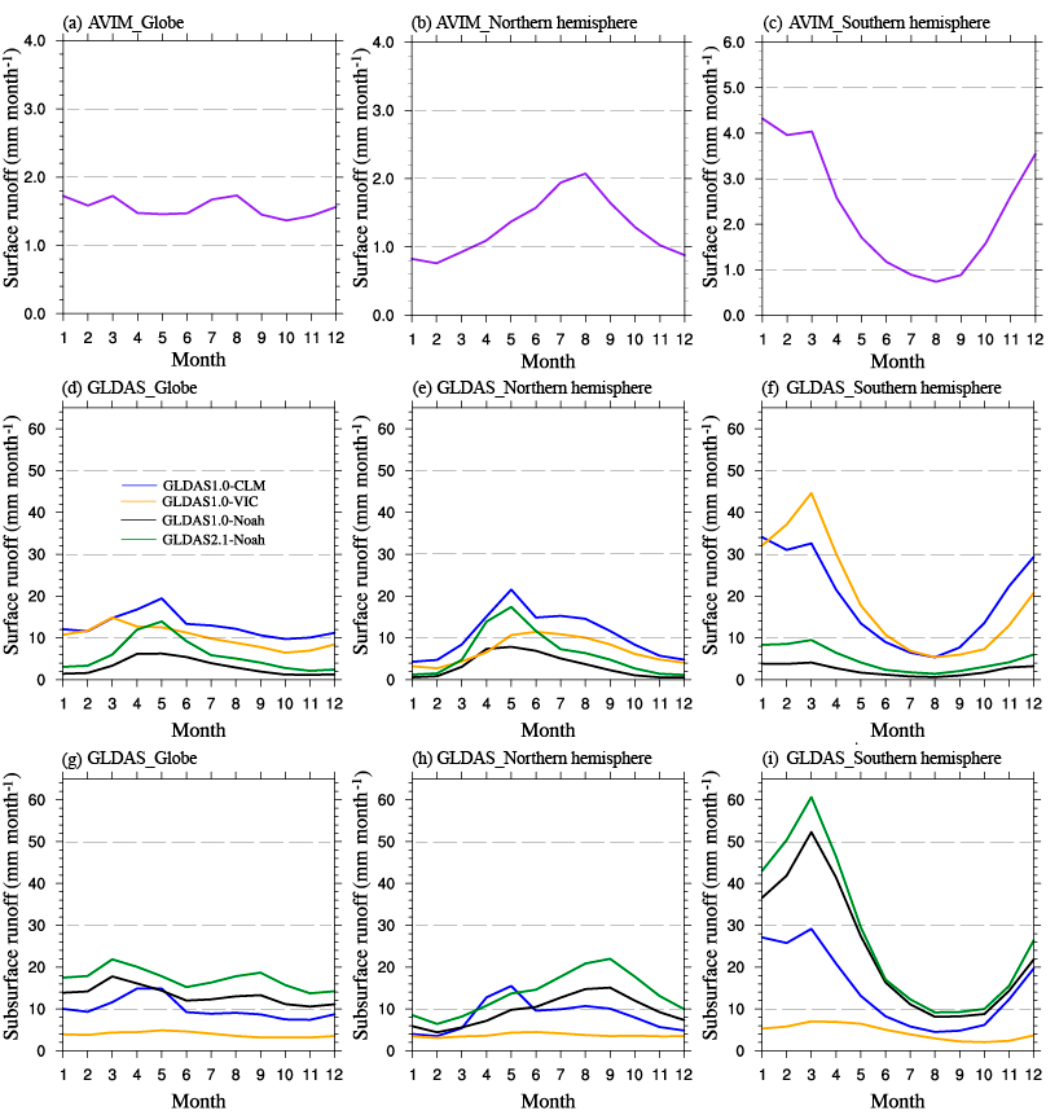
Figure 1. Annual cycle of the AVIM area-weighted mean surface runoff globally ( a ), in the Northern Hemisphere ( b ) and in the Southern Hemisphere ( c ). The GLDAS area-weighted mean surface runoff globally ( d ), in the Northern Hemisphere ( e ) and in the Southern Hemisphere ( f ). The GLDAS area-weighted mean subsurface runoff globally ( g ), in the Northern Hemisphere ( h ) and in the Southern Hemisphere ( i ). ( d – i ) were reproduced from Lv et al. [35].